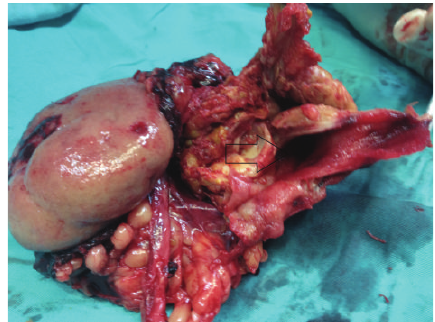
Figure 2: An intraparenchymal renal artery aneurysm.